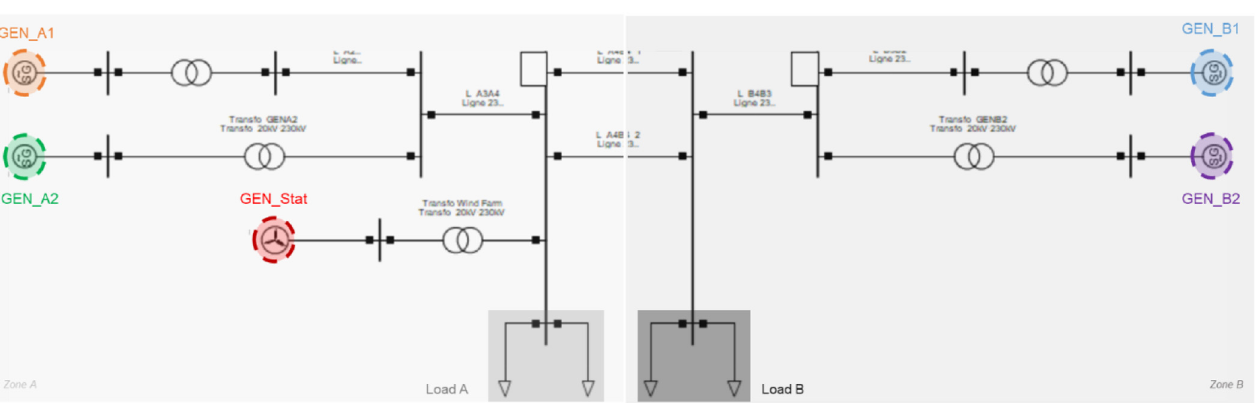
Fig. 2. Kundur ’ s power system with additional RES